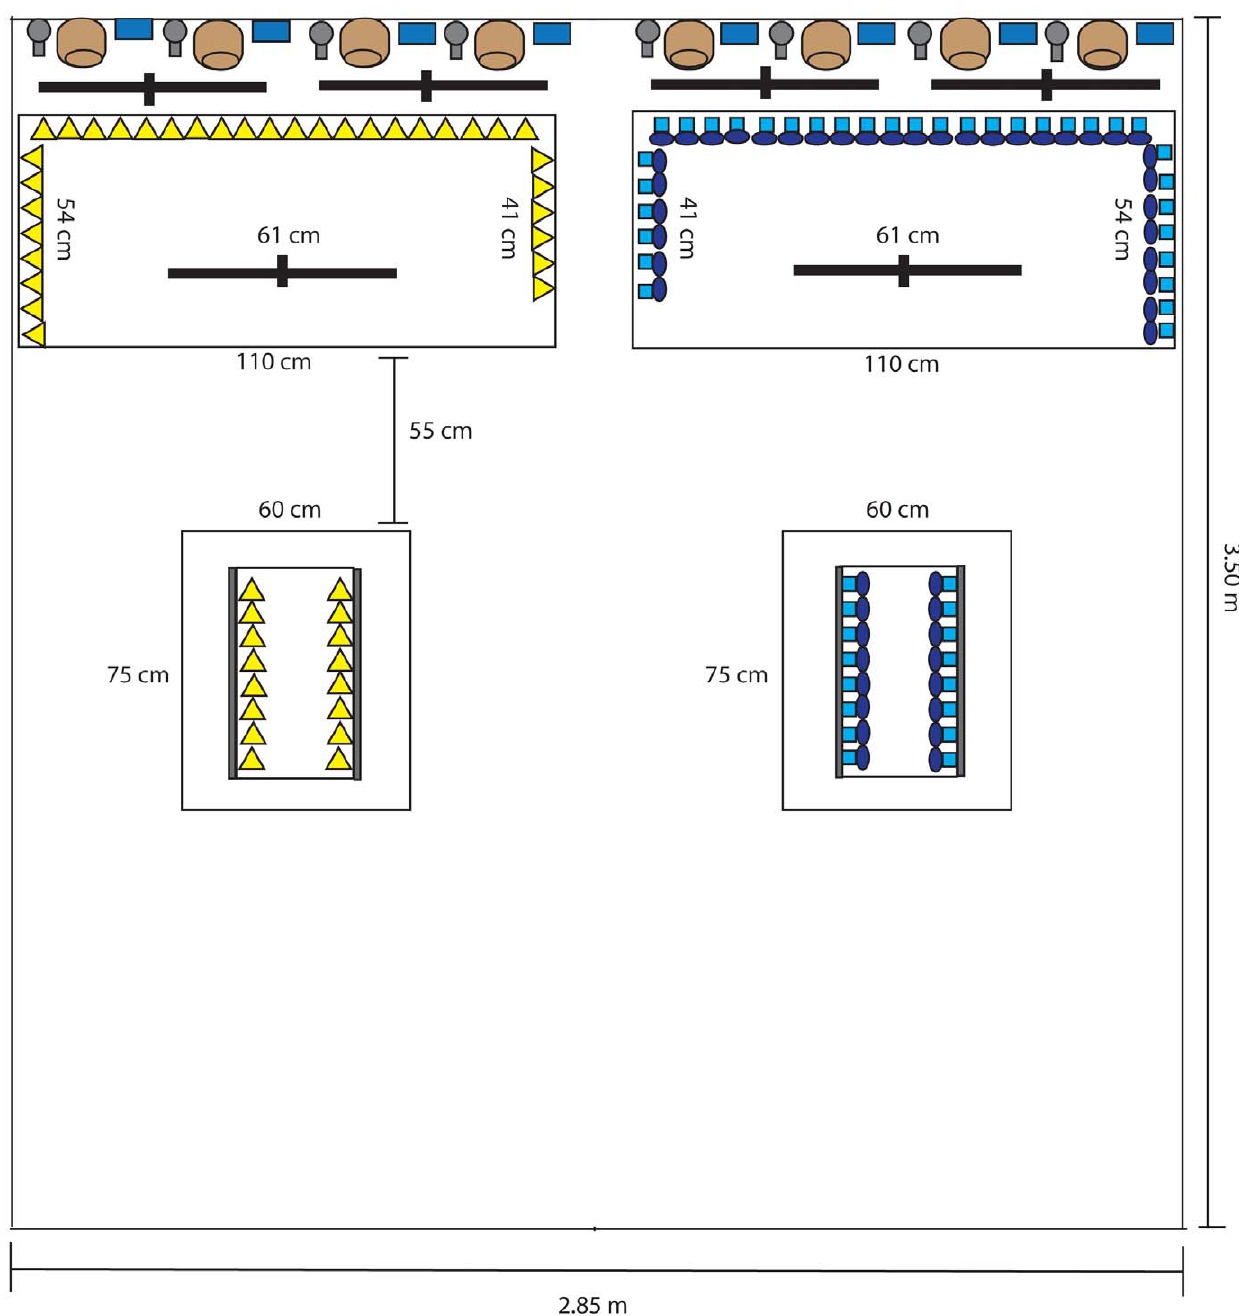
Figure 3. The thick black bars indicate perches, the brown cylindrical objects are nest baskets, the small blue rectangles are nest- material dispensers and the small grey circular objects are water bottles. The left side of the aviary contained the stalk habitat and the right side the lid habitat. The four white rectangles with foraging task symbols represent the foraging patches. The two patches in the middle contained 16 stalk or 16 lid tasks each, whereas the patches next to the nest boxes contained 34 stalk or 34 lid tasks each. The aviary was 2.3 m high. Foraging patches were placed on tables 90 cm above the aviary floor to facilitate the recording of all foraging occurrences and social interactions. Nest baskets, nest material dispensers and water bottles were positioned 50 cm above the tables with foraging patches. model that contained the following fixed effects: training treatment (i.e. lid or stalk), test trial number, lid male’s identity, colour of lid male’s leg bands, lid male’s performance during observation phase and stalk male’s performance during observation phase. Random